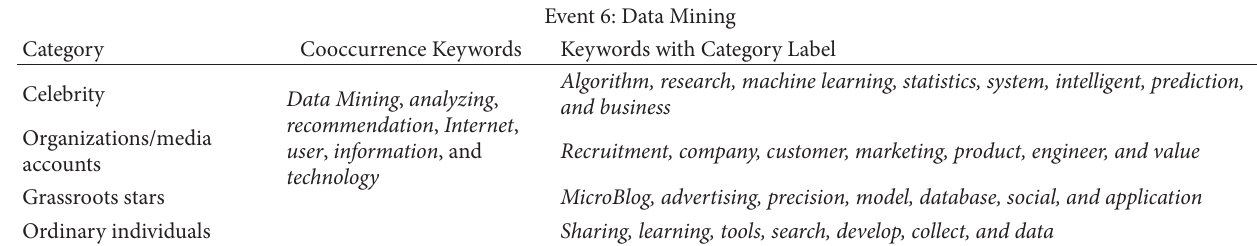
Table 10: Keywords distribution on the event of “Data Mining.”